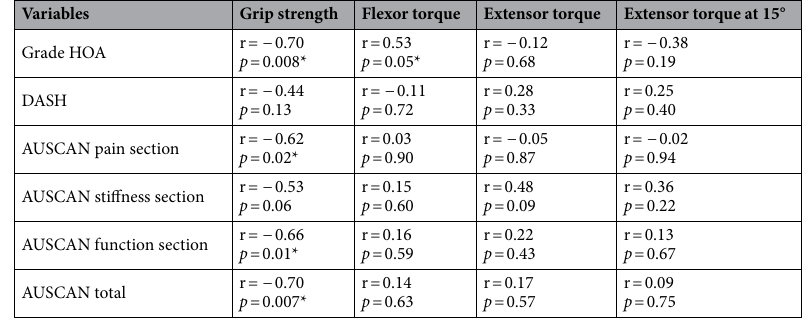
Table 3. Correlations between grip strength and torque and variables in HOAG. *Significant